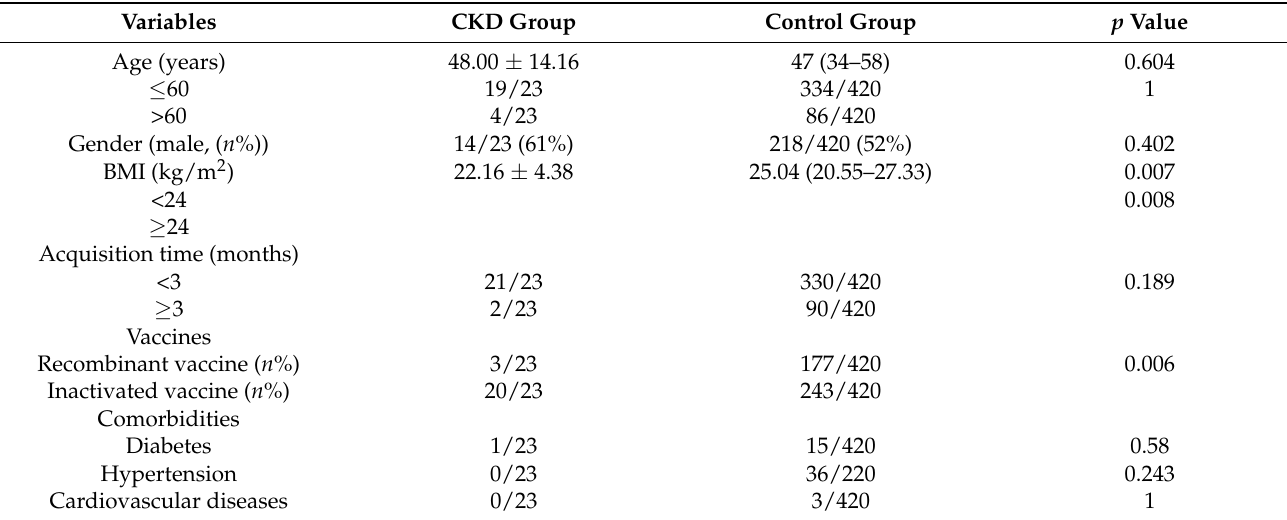
Table 3. Baseline characteristics of the hemodialysis CKD patients and healthy